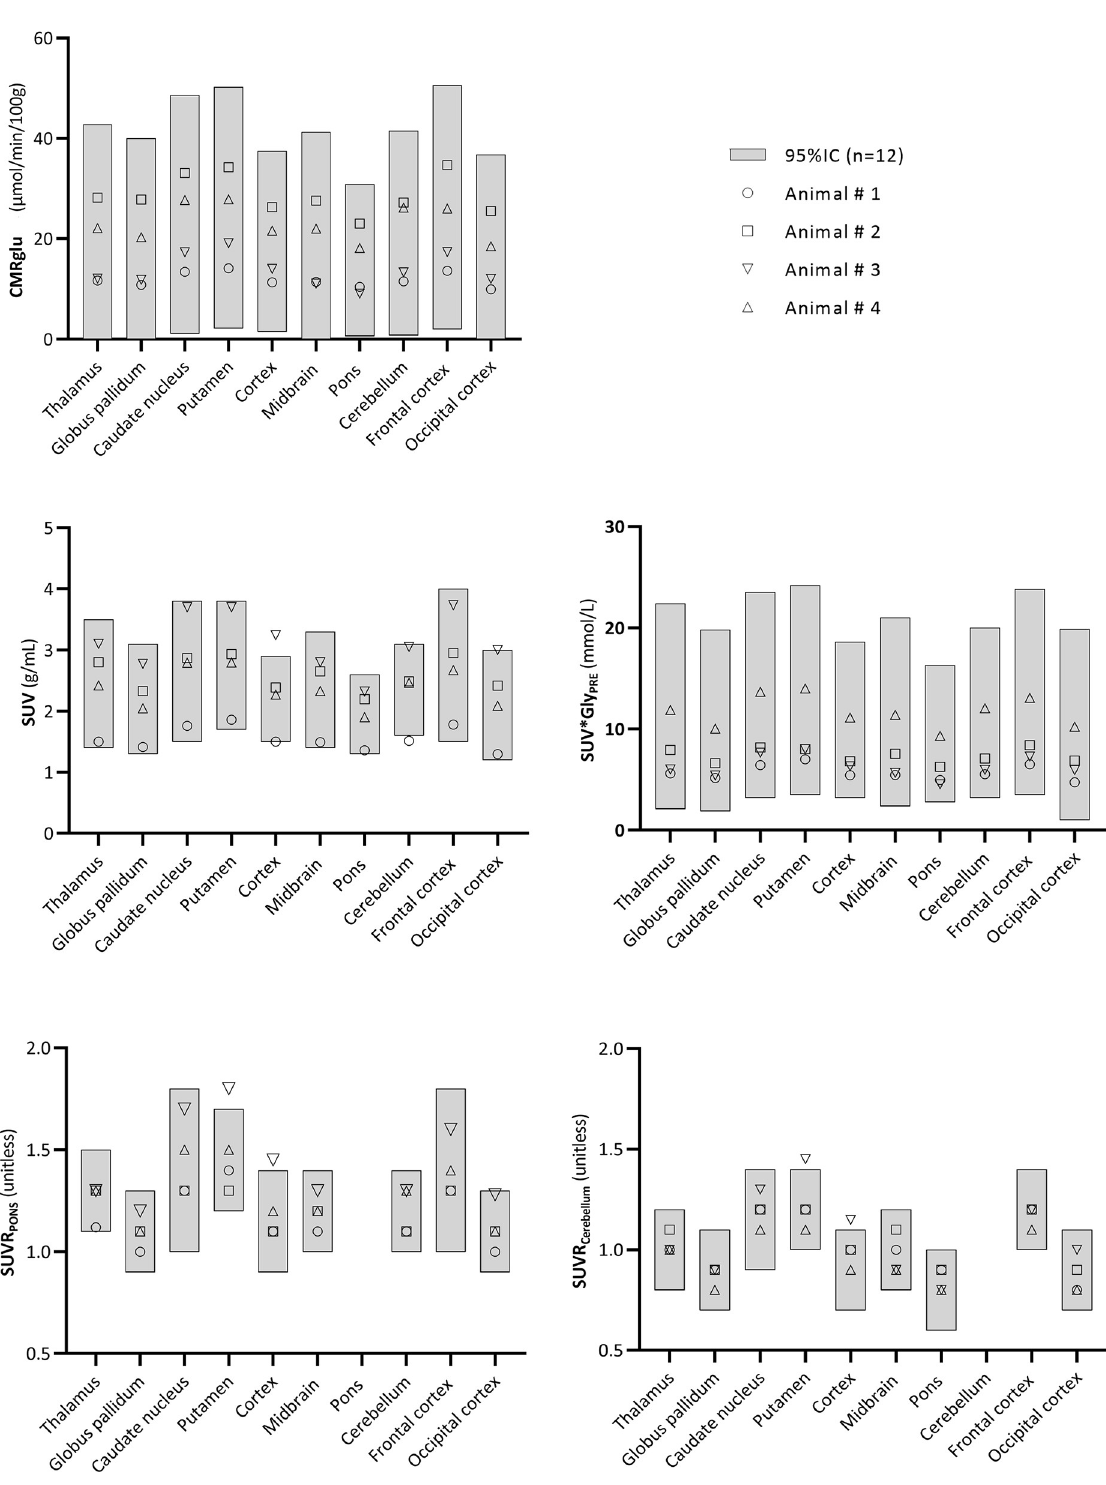
Fig 2. Robustness study. Grey boxes represent the 95%IC of each parameter. Four naive animals were considered for this study and regional estimates are represented for each animal and region.